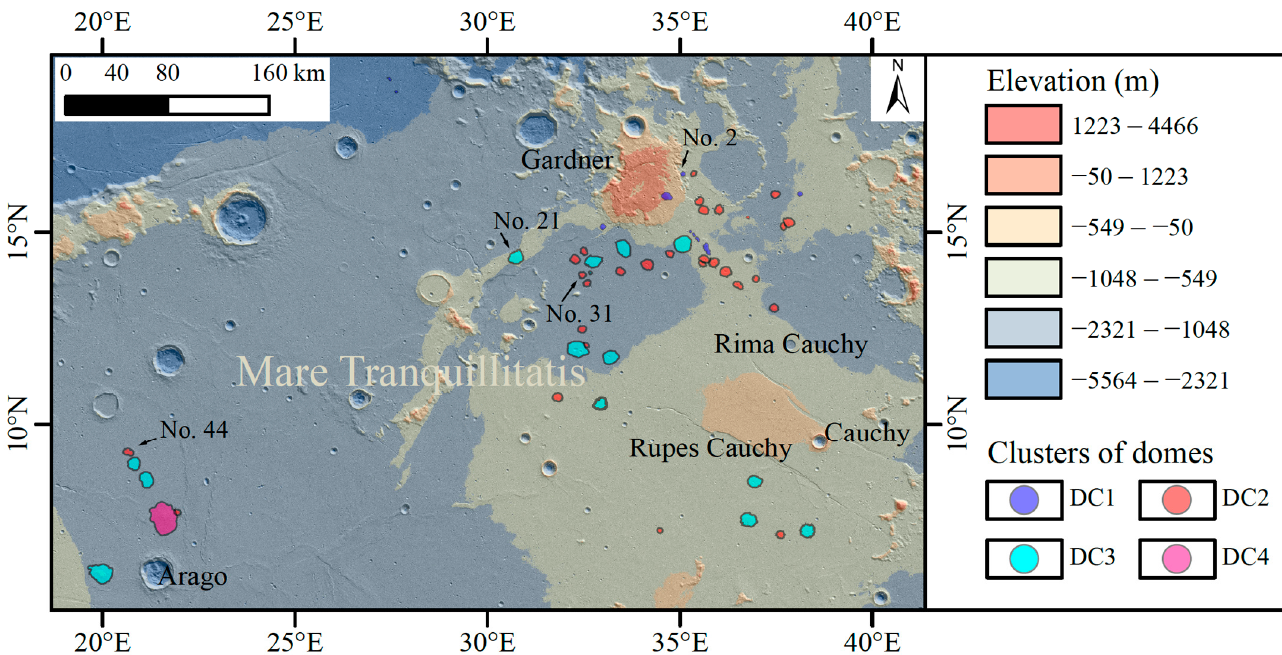
Figure 4. Distributions of the clustered domes. DC1 to DC4 represent the four obtained clusters. The shapes of domes in the figure correspond to their real shapes. The background is a topographic map derived from TC DTM (simple cylindrical projection).